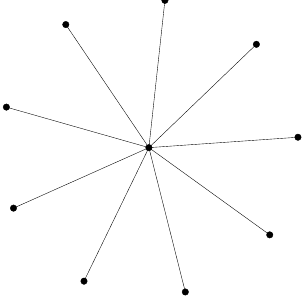
Figure 3. Graphical representation of a star communication structure, also known as wheel architec- ture, with ten particles.